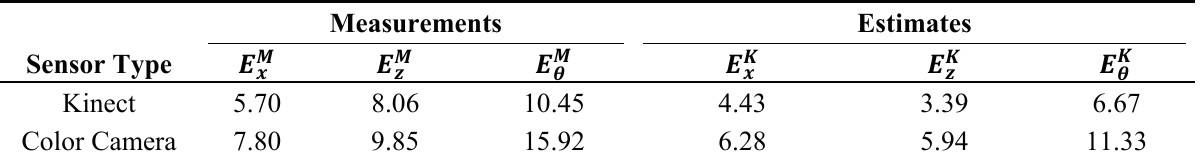
Table 2. MSE errors of human tracking using different sensor types in each feature dimension: x , z , and θ ; the unit is cm, cm, and degree, respectively.